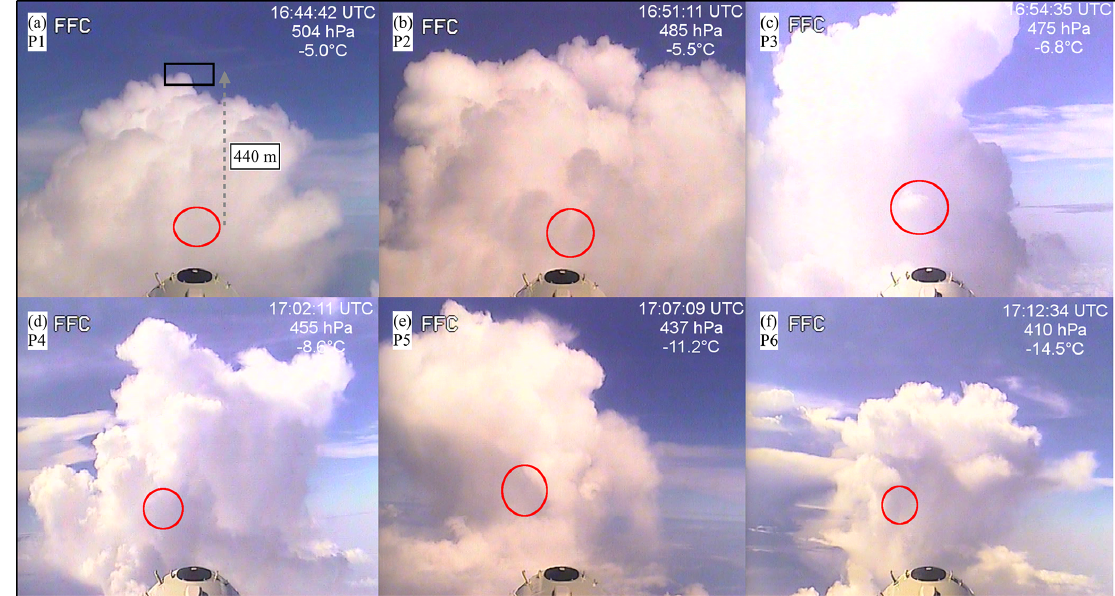
Figure 4. Images from the forward-facing camera on the BAe-146 aircraft immediately before cloud penetrations (marked by red circles). Penetrations P1 to P6 are shown (from top left to bottom right). Temperatures are from the in situ measurements out of cloud prior to each penetration. (a) P1 has the cloud top marked by a black box. The grey arrow marks distance to cloud top from penetration of